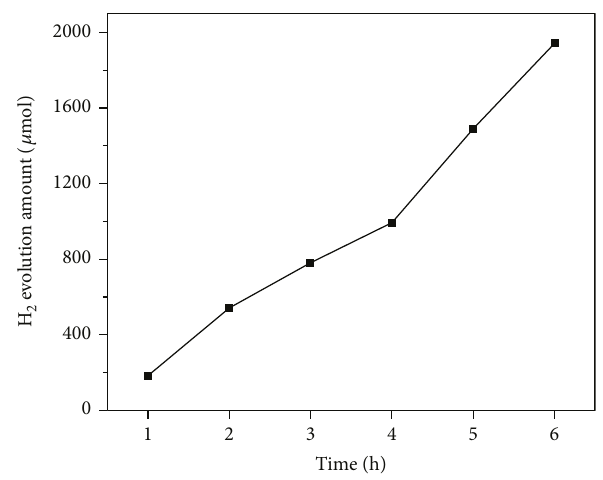
Figure 6: The hydrogen production of the TCF15 under UV light